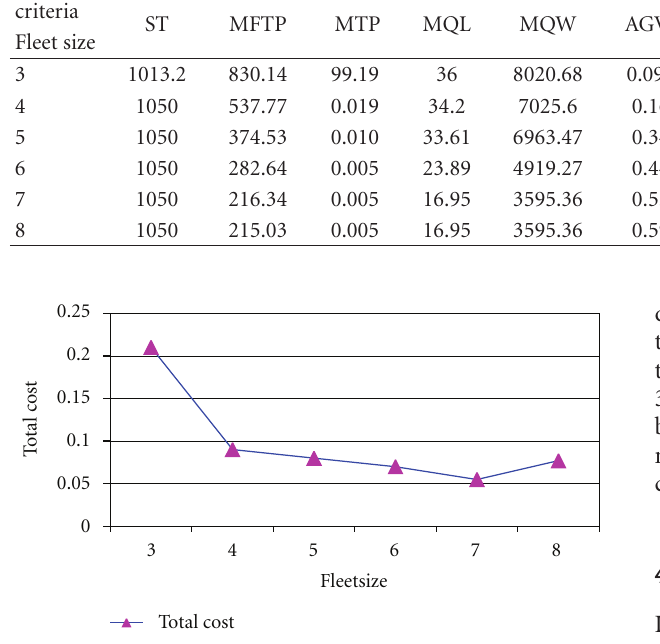
Figure 8: Total cost versus di ff erent fleet